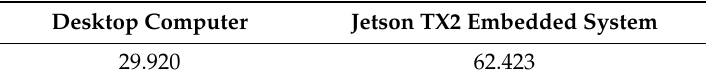
Figure 13. NVIDIA Jetson TX2 on-board embedded system. Table 12. Processing time of proposed method on a desktop general purpose computer and a Jetson TX2 embedded system (unit: